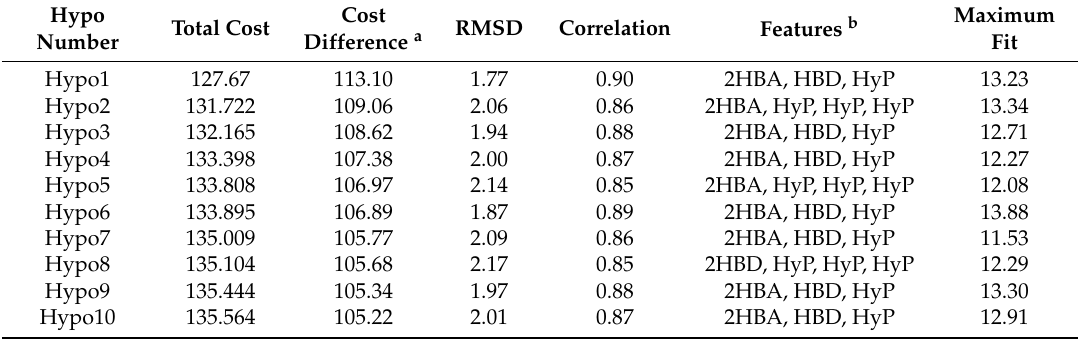
Table 1. Statistical information of 10 pharmacophore hypotheses derived by HypoGen.